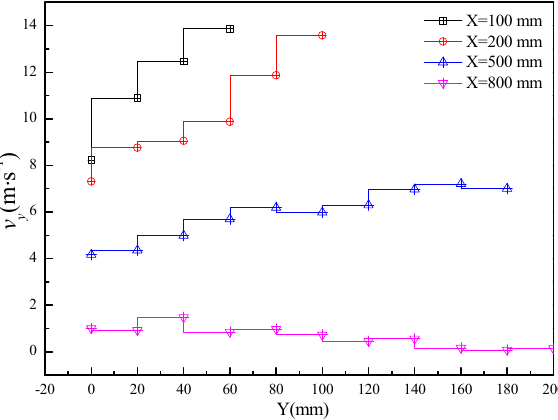
Figure 11. Comparison curve of the radial velocity along the radial direction.